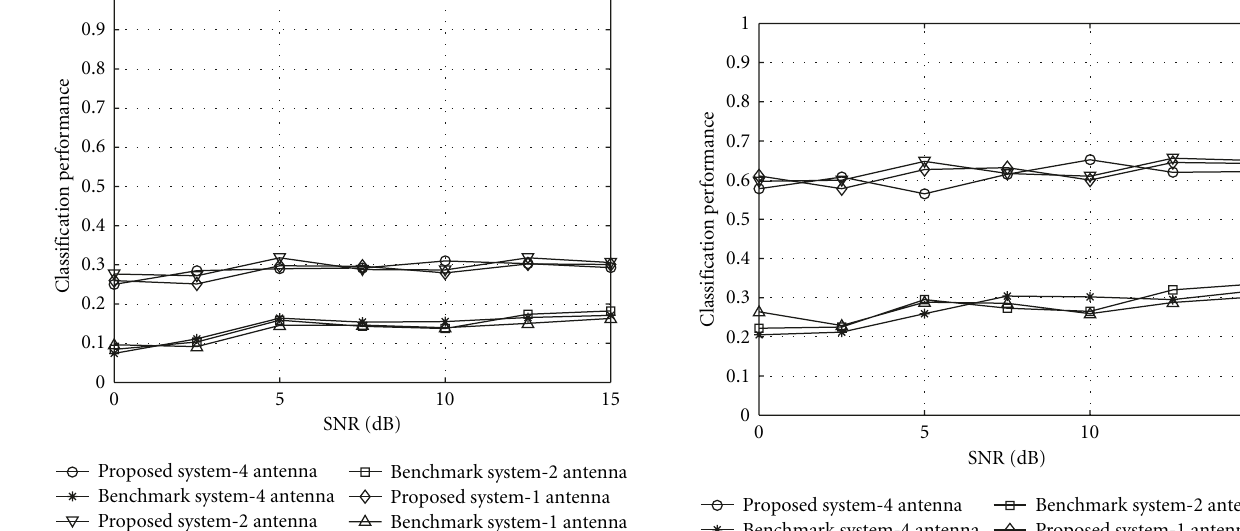
Figure 15: Final classification performance of proposed classifier and benchmark in a slow 20-path fading channel using SC.